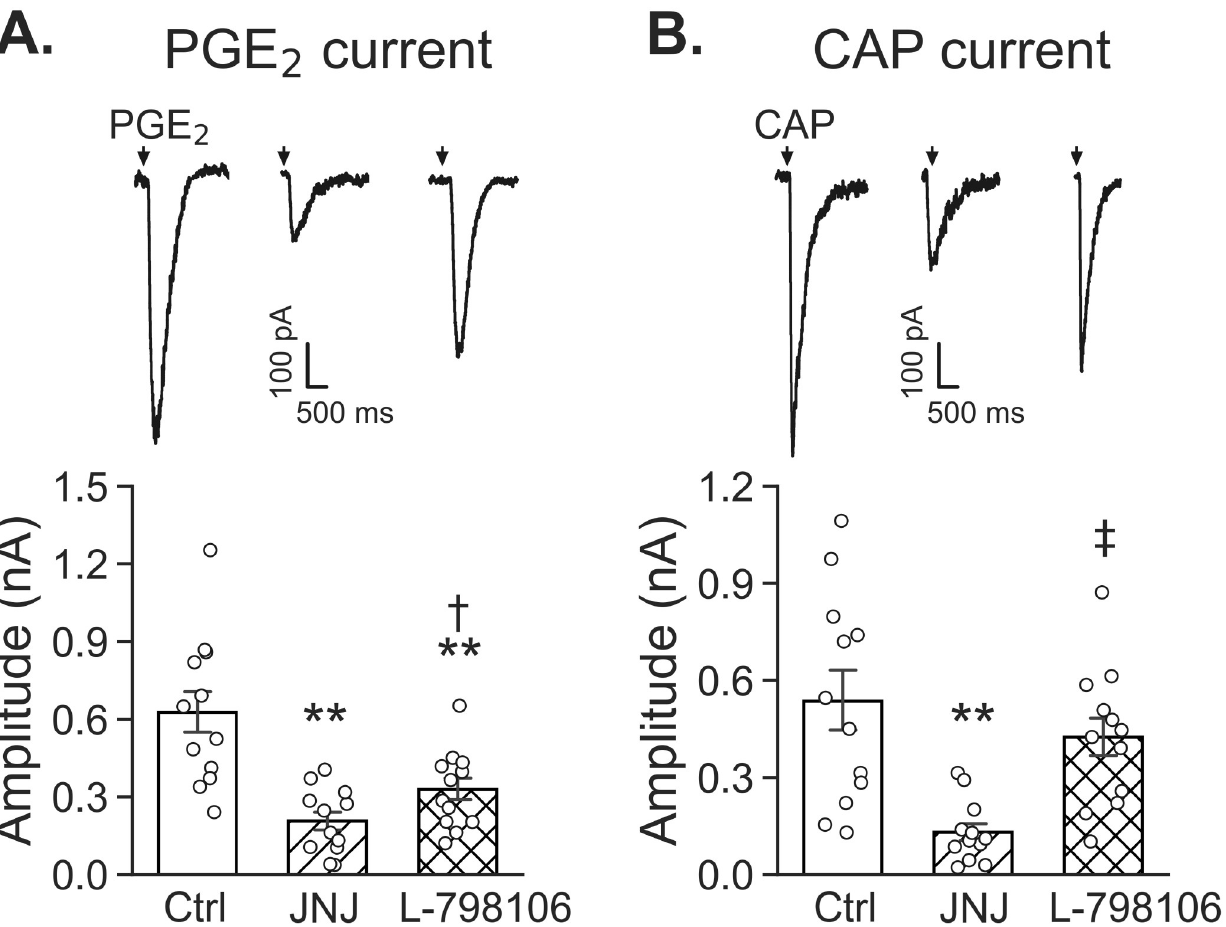
Fig 5. The effects of JNJ 17203212 (JNJ) and L-798106 on the PGE 2 - (A) and CAP-induced currents (B) respectively. The amplitudes of PGE 2 -induced currents are inhibited by both JNJ 17203212 and L-798106, but those of CAP-induced currents are suppressed by JNJ 17203212 and not by L-798106. JNJ 17203212 (20 μ M) or L-798106 (6 μ M) is applied into the bath solution 30 min ahead of recording (n = 12 for each group). � P < 0.05 and �� P < 0.01 as compared to Ctrl. † P < 0.05 and ‡ P < 0.01, L-798106 vs. JNJ 17203212